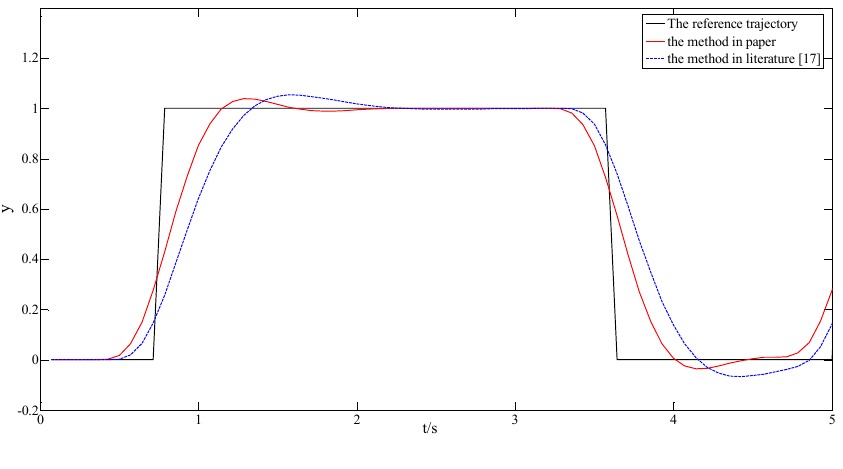
Figure 11. Square-wave tracking comparison with added white